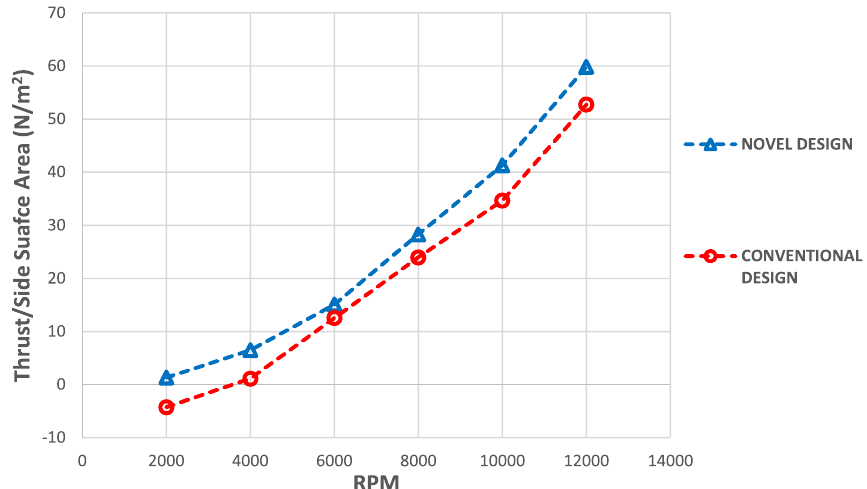
Fig. 9 Thrust per side surface area vs RPM for novel and conventional design